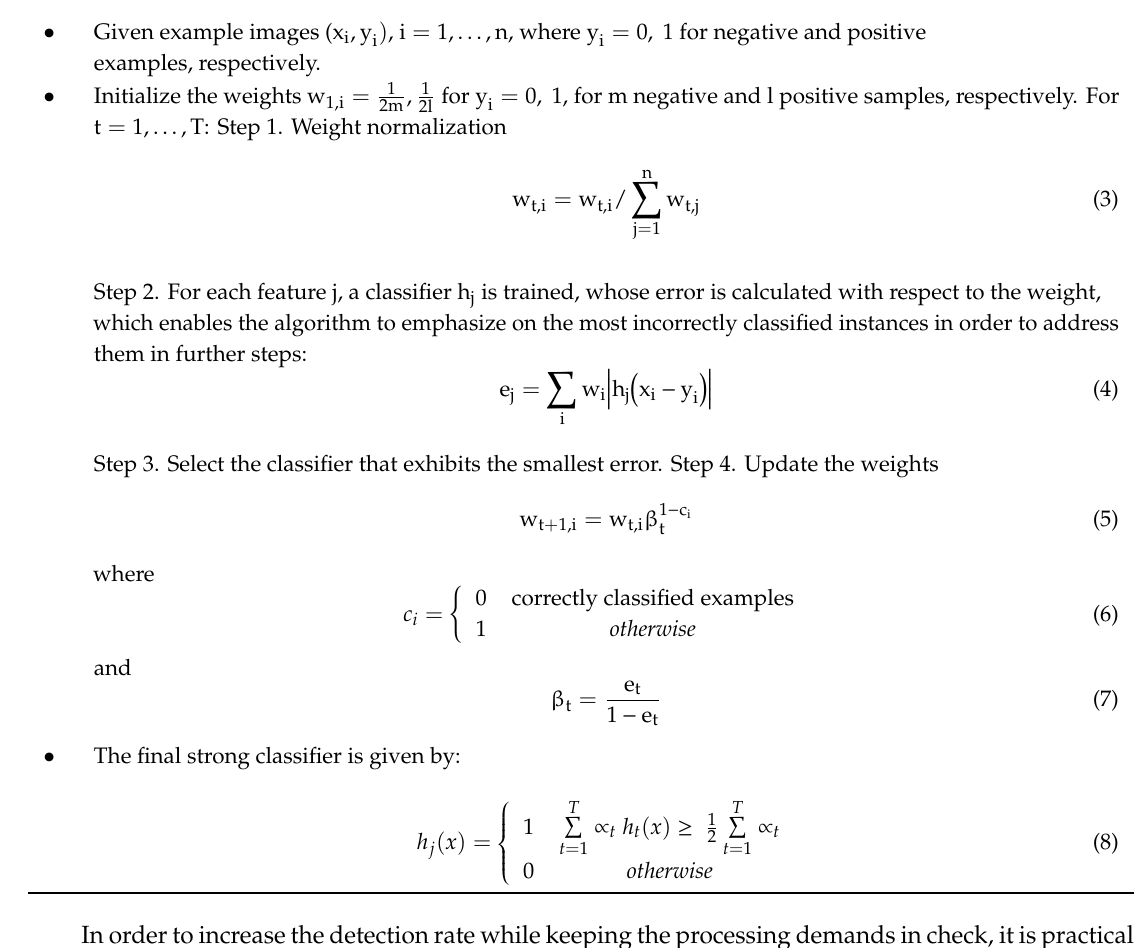
Algorithm 1. AdaBoost training